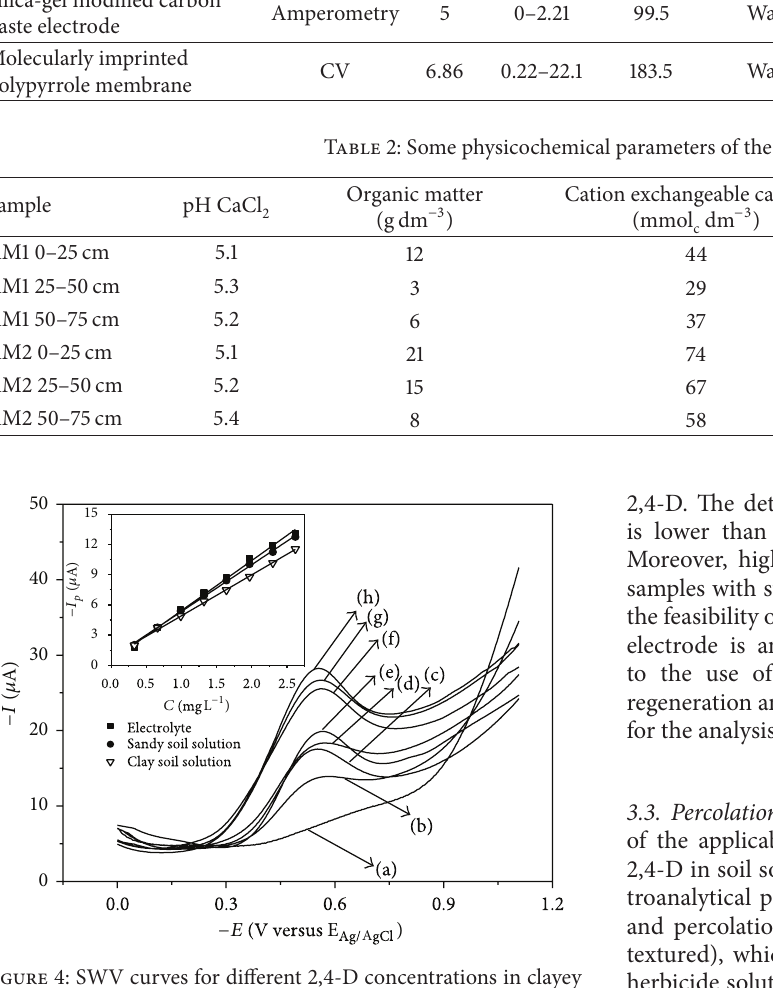
= − 0.40 V, and 𝑡 = 10 s. Inset: acc acc